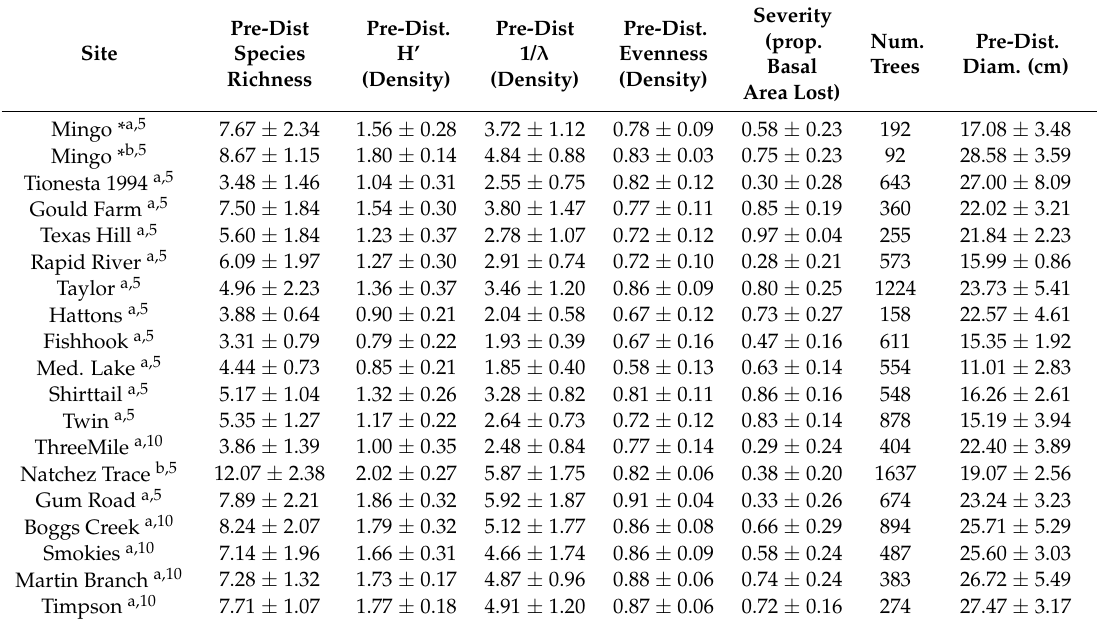
Table 1. Study site names, pre-disturbance vegetation characteristics, number of trees sampled, and disturbance severity. Values are means ± standard deviation across